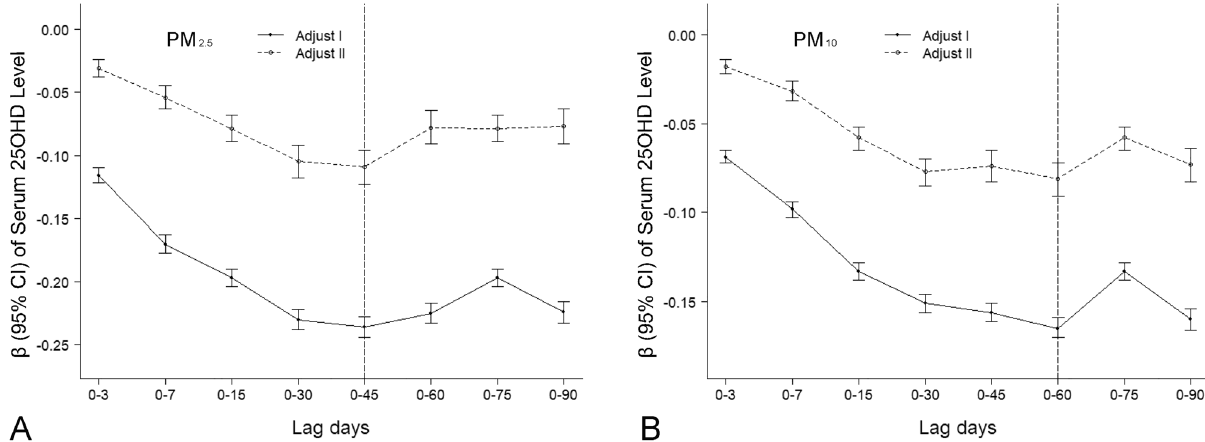
Figure 2. Association among exposure to PM 2.5 ( A ) or PM 10 ( B ) and maternal serum 25OHD levels during pregnancy. The cumulative effects of PM were divided into four levels based on quartiles. After adjusting for year and age at blood collection (adjust I) or year, season, and age at blood collection (adjust II), the β-values (95% CI) of maternal serum 25OHD levels during pregnancy were calculated based on the group trend. The dashed vertical line represents lag days corresponding to the maximum cumulative effects. 25OHD 25-hydroxy vitamin D, PM